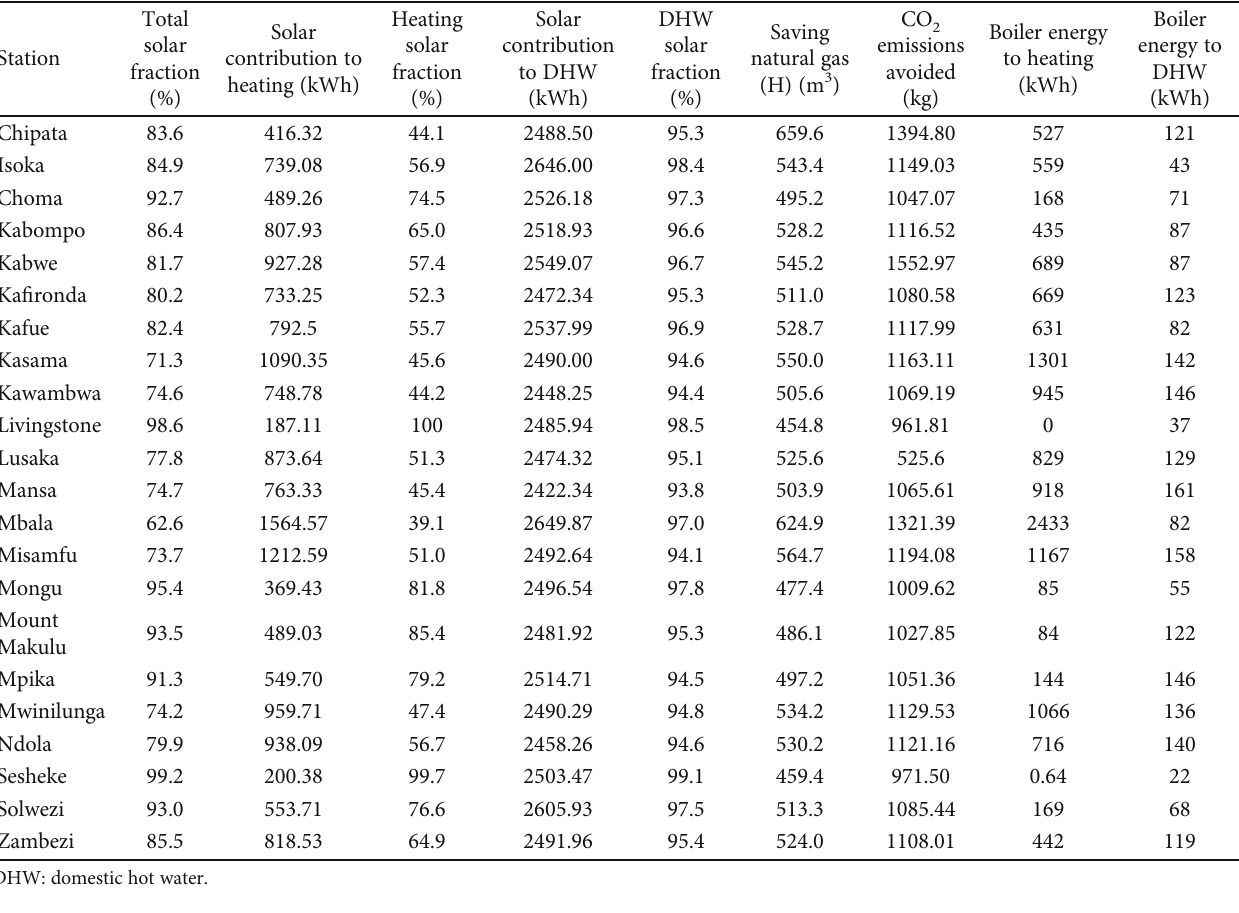
Table 3: The results of the studied parameters per